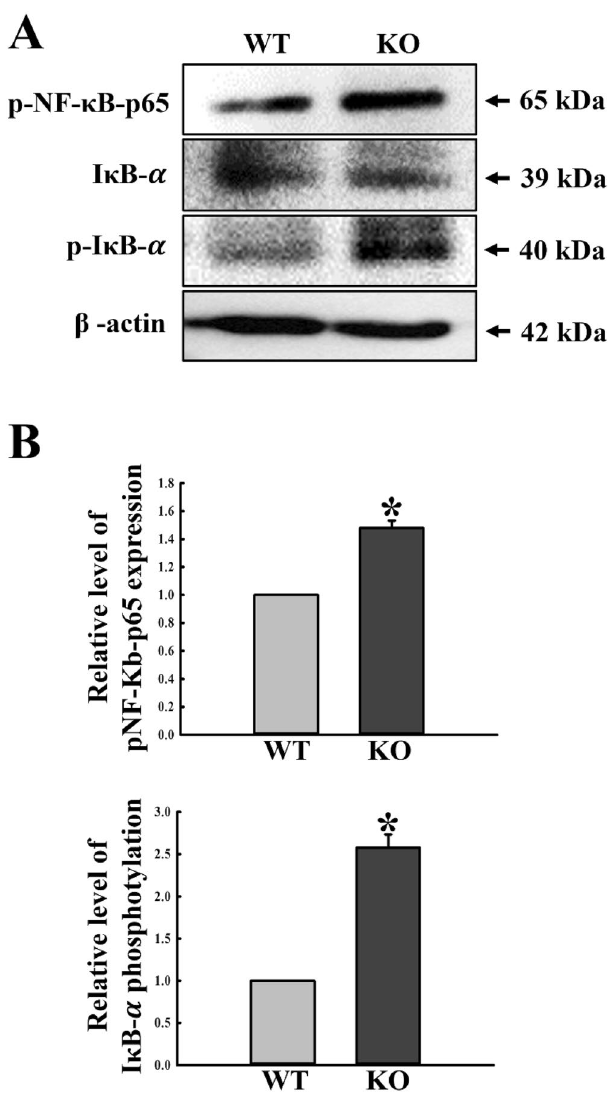
Figure 5. Expression levels of members in the NF-κB signaling pathway. ( A ) Expression levels of NF-κB-p65 and IκB-α proteins were determined by Western blot analysis using specific primary antibody and HRP-labeled anti-rabbit IgG antibody. ( B ) Band intensities were determined using an imaging densitometer, and protein expressions were calculated relative to the intensity of β-actin. Tissue samples were collected from 3 to 5 mice per group, and each lysate was analyzed in duplicate for Western blot (final n = 6–10). Data are reported as the mean ± SD. * indicates p < 0.05 compared to the WT